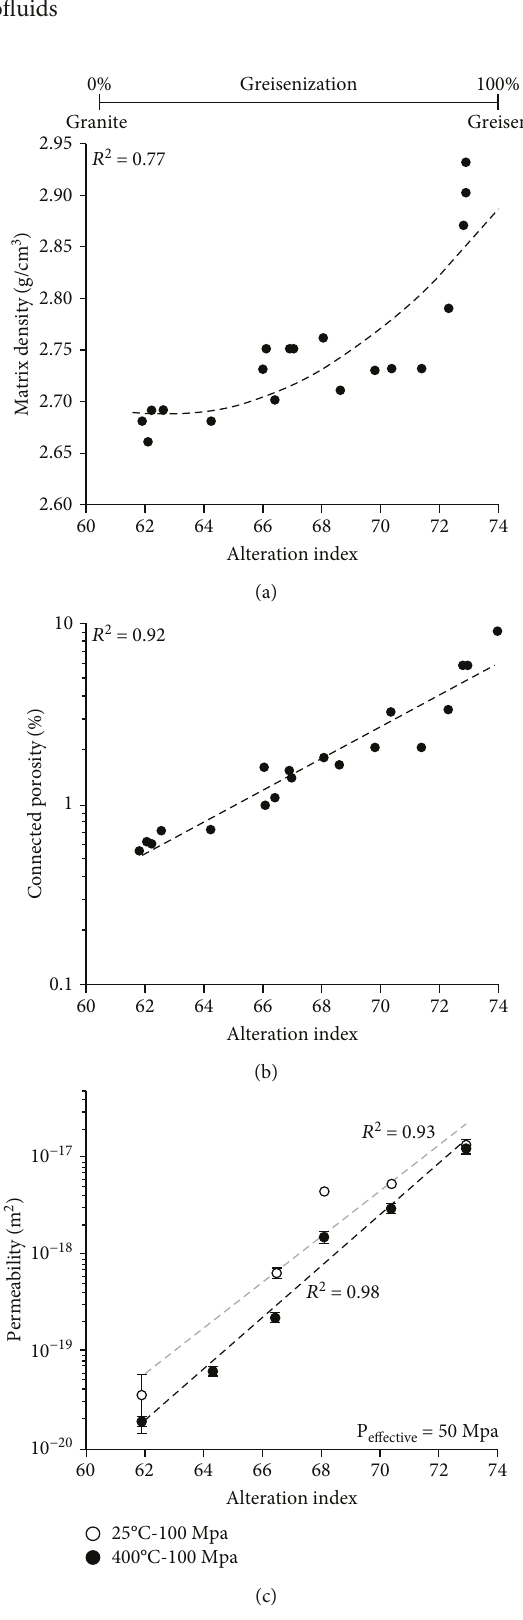
Figure 10: Evolution of (a) matrix density, (b) connected porosity, and (c) permeability as a function of the chemical alteration index (AI). The AI increases upon greisen alteration (see the top horizontal qualitative axis and Section 4.3 for